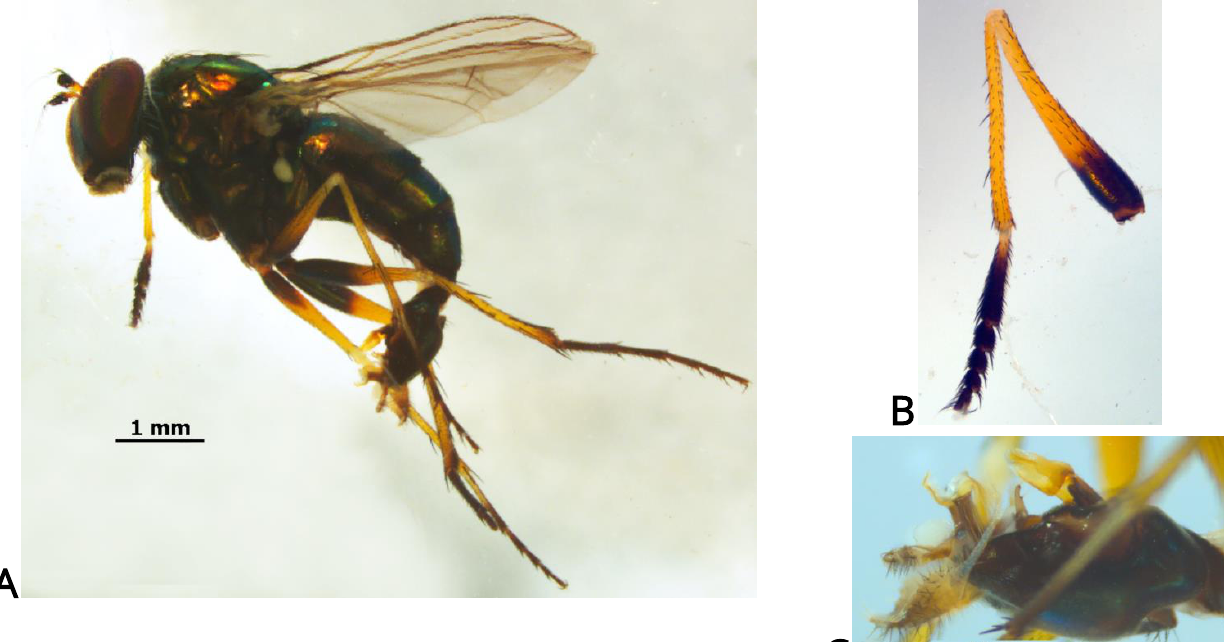
Figs. 6. Tachytrechus planitarsis Becker, 1907: A-male habitus; B-fore leg;